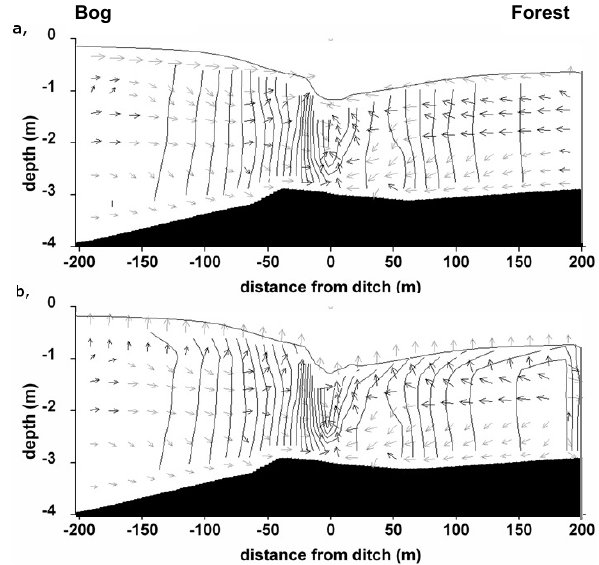
Fig. 5. Results of the steady-state simulation (a) and of the transient simulation (b) represented by the hydraulic conditions on 4 Septem- ber. Note that the simulation domain is bordered by no-flow bound- aries at the west and east end, and at the boundary to the under- lying clay layer. Illustrated is the water table, hydraulic potentials in 0.05m contours, flow direction (black arrows indicate upward groundwater flow and grey arrows downward flow) and flow veloc- ity (arrow size). Peat depth is vertically exaggerated.